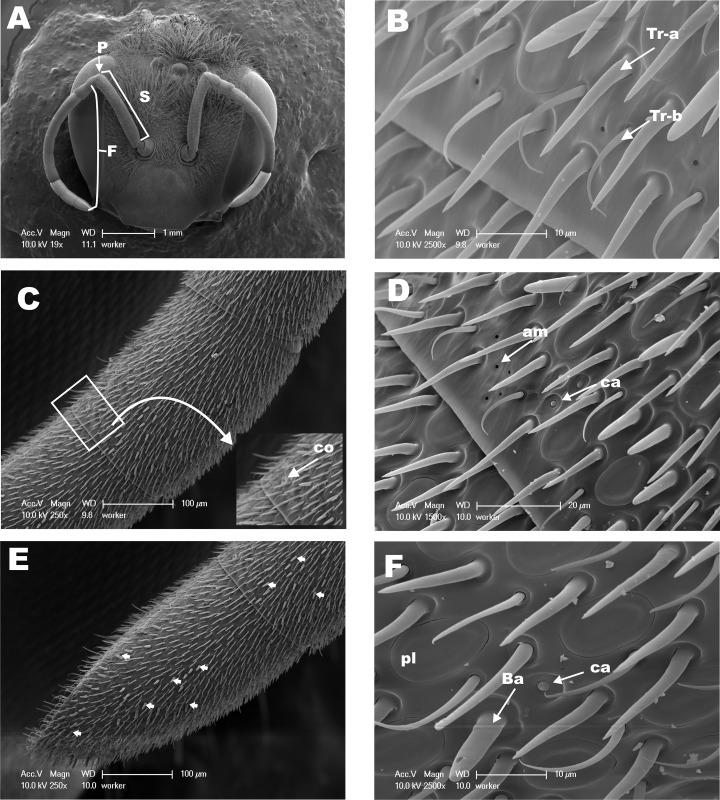
Scanning Electron Micrographs (SEM) from dorsal side of antennae of M. scutellaris worker.(A) View of the head and dorsal surface of the antennae; pedicel (P), scape (S) and flagellum (F). (B) Distal view of flagellomere 8 highlighting sensilla trichodea a (Tr-a) and b (Tr-b). (C) Snapshot of flagellomere 9, flanked by flagellomeres 8 and 10 on the right and left sides, respectively; zoomed area of flagellomere 9 highlighting the sensillum coeloconica (co). (D) Higher magnification of flagellomere 9 highlighting the sensilla campaniformia (ca) and ampullaceal (am). (E) Flagellomere 10 and distal limit of flagellomere 9 showing a large number of sensilla basiconica, some of them are indicated by arrows. (F) High magnification of flagellomere 10 showing sensilla basiconica (Ba), placodea (pl) and campaniformia (ca).